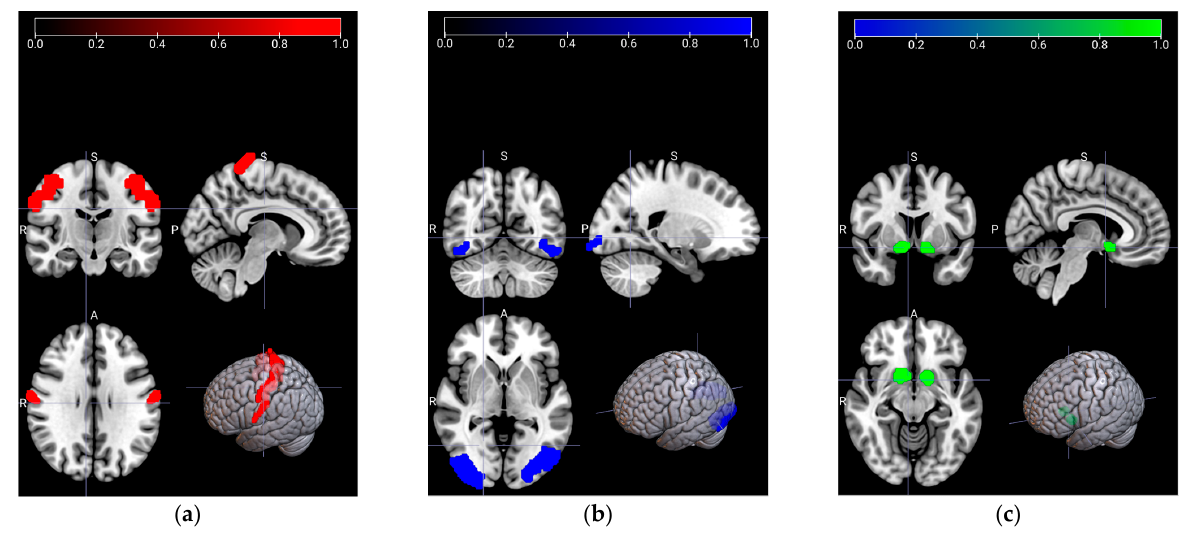
Figure 2. The region-of-interest (ROIs) of the task-related areas are illustrated in coronal, sagittal (top row), and axial (bottom row-left) anatomical sections, respectively, as well as with the locations in the rendered brain (bottom row-right). ( a ) Nucleus Accumbens (NAcc), shown in green, is associated with the reward-related activities; ( b ) Broadmann Area-4 (BA4), shown in red, is related to motor movements; ( c ) Occipital Face Area (OFA), shown in blue, is related to face processing and recognition.